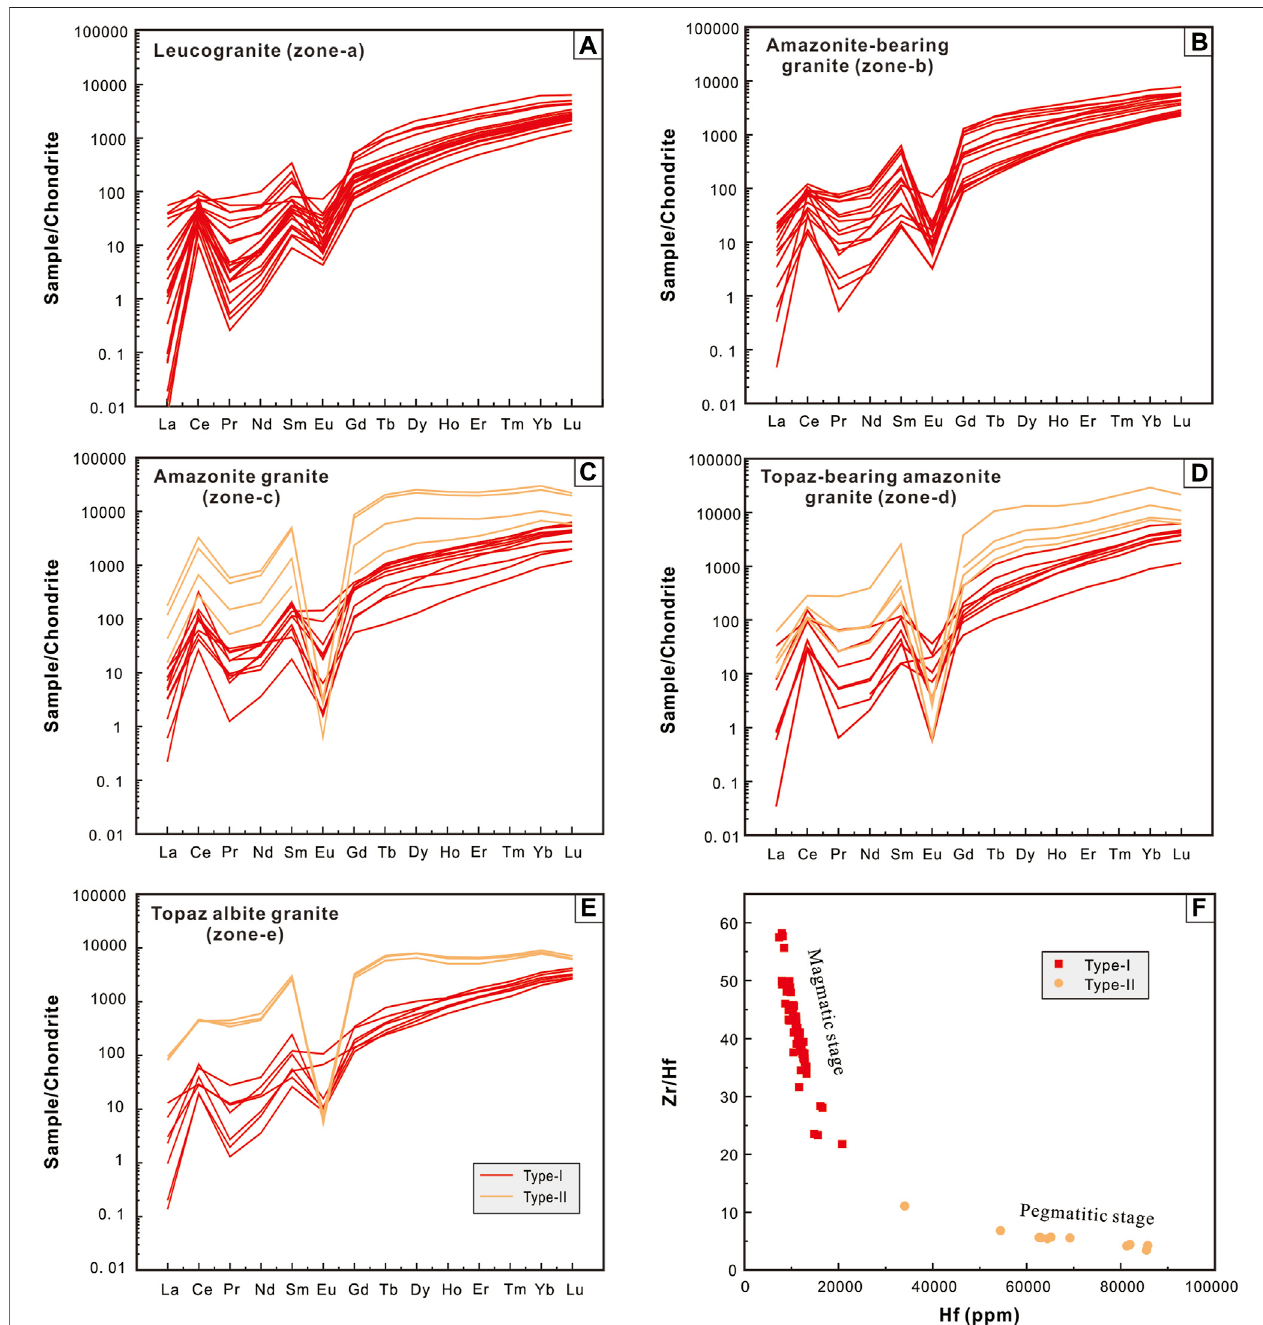
FIGURE8|(A – E) Chondrite – normalized REEdistributionpatternsand (F) Zr – HffractionationtrendsfortwotypesofzirconfromtheeachzonesoftheBSTpluton. Values for magmatic stage and pegmatitic stage are from Wang et al. (2010) and Han et al. (2019) and reference therein.